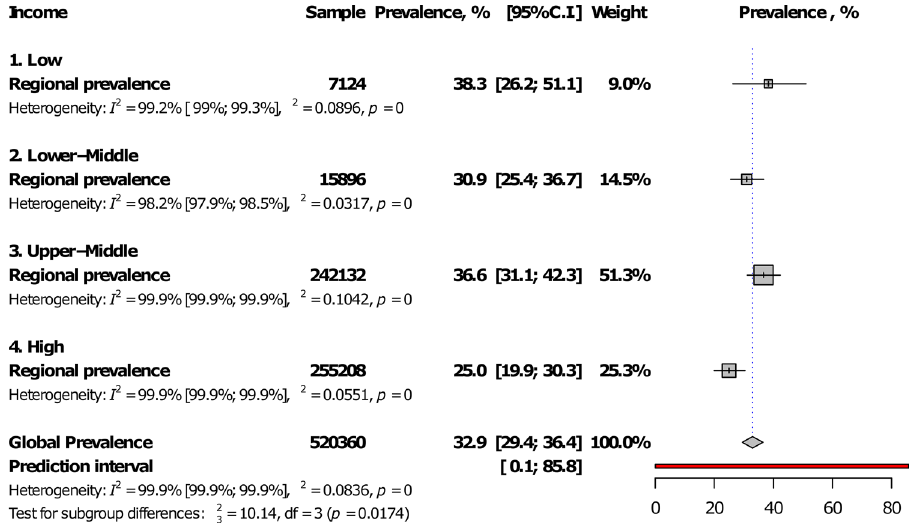
Figure 6. Meta-analysis prevalence of Toxoplasma gondii immunoglobulins G seroprevalence in pregnant women by country level of